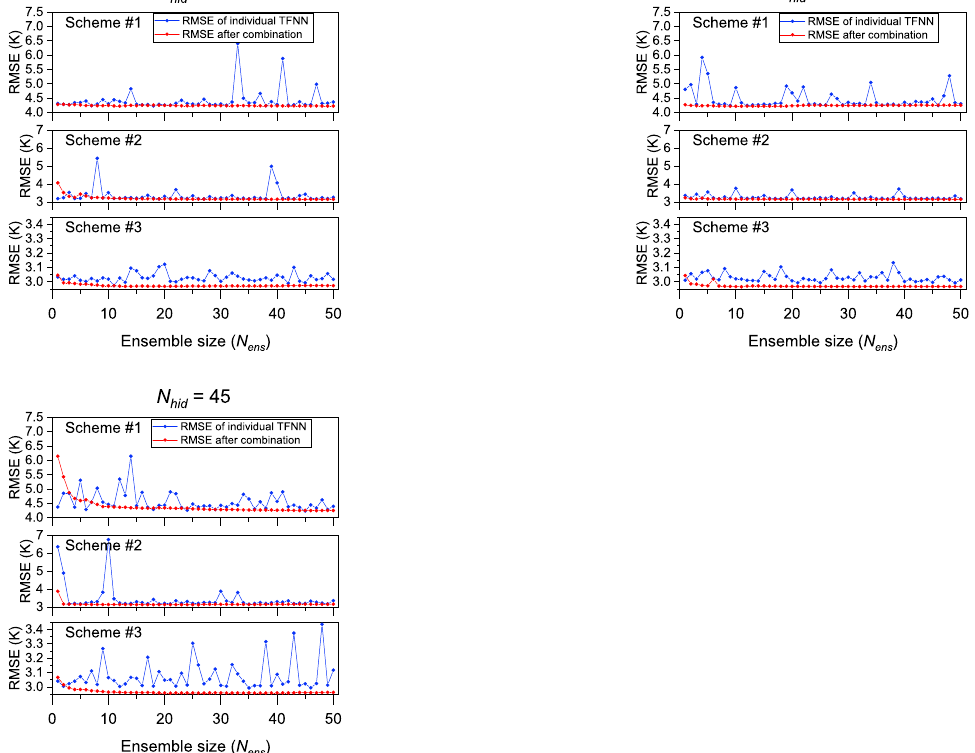
Figure 7. RMSEs of different modeling schemes after combination under different ensemble sizes ( N hid =